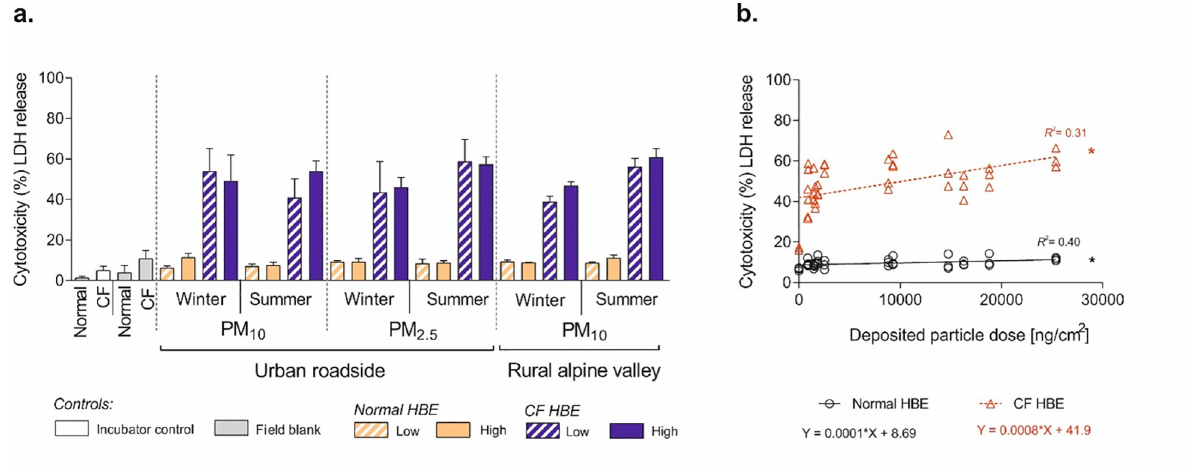
Fig 1. Cytotoxicity in normal and cystic fibrosis (CF) human bronchial epithelia (HBE) 24 h after exposure to seasonally sampled PM from either an urban roadside (Bern) or a rural alpine valley (Magadino). ( a ) Cytotoxicity presented as percentage of total lactate dehydrogenase (LDH) released from damaged cells into the apical compartment. Low dose deposited on HBE = 0.9–2.5 μ g per cm 2 of cell culture area, high dose = 8.8–25.4 μ g/cm 2 . The data are presented as mean values and error bars representing 1 standard deviation (SD) of three independent experiments with triplicate cell cultures (total n = 9 cell cultures). ANOVA, Dunnett’s multiple comparison). ( b ) Scatter plot and corresponding regression line for normal and CF HBE, evaluating the relationship of cytotoxicity and deposited particle dose (repeated measurements at the same dose are displayed for visualization). � p-value < 0.05 compared to filter blank. Abbreviation: R 2 = R-square linear coefficient of determination. https://doi.org/10.1371/journal.pone.0233425.g001 by enhanced levels of the cytoplasmic enzyme lactate dehydrogenase (LDH) released from damaged cells into the apical compartment, on average 2.2 fold in normal ( p-value = 0.0395)